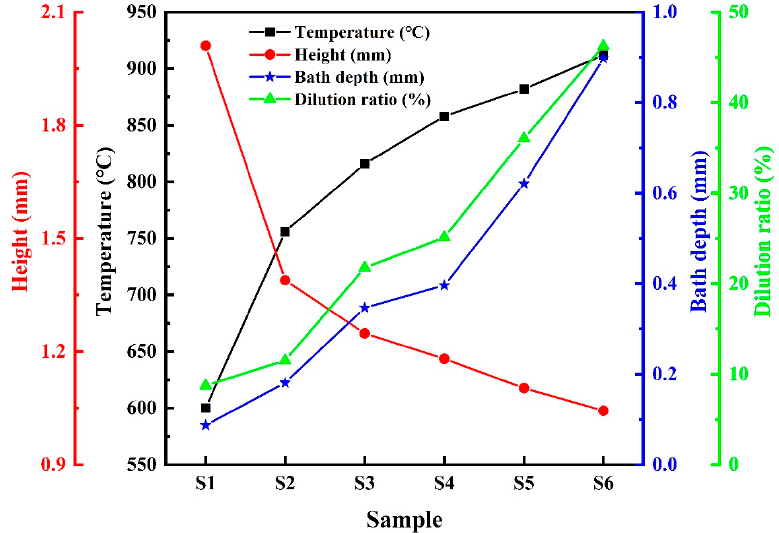
Figure 4. Variation curves of temperature, height, bath depth and dilution ratio with the progress of cladding. of